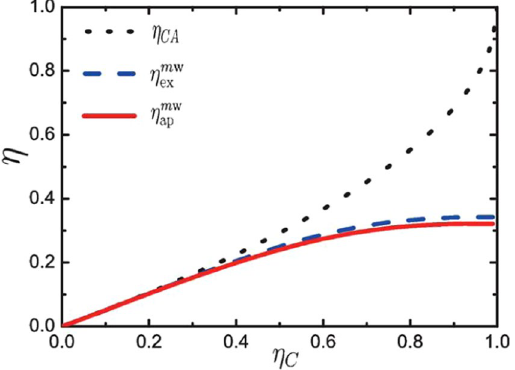
Figure 2. The maximum-work efficiency η m w or the CA efficiency η CA as a function of the Carnot efficiency η C . w are denoted by a blue dashed line and The approximate and exact results of the optimal efficiency, η m apw and η m ex a red solid line, respectively, while the CA efficiency η CA is represented by a black dotted line. Here the parameters are N = 100, α = 3, γ = − 3, and = = = r r r 1 1 2 3